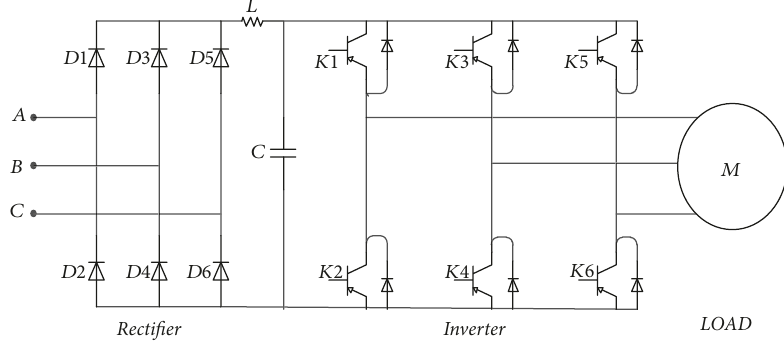
Figure 1: Structure of a three-phase two-level